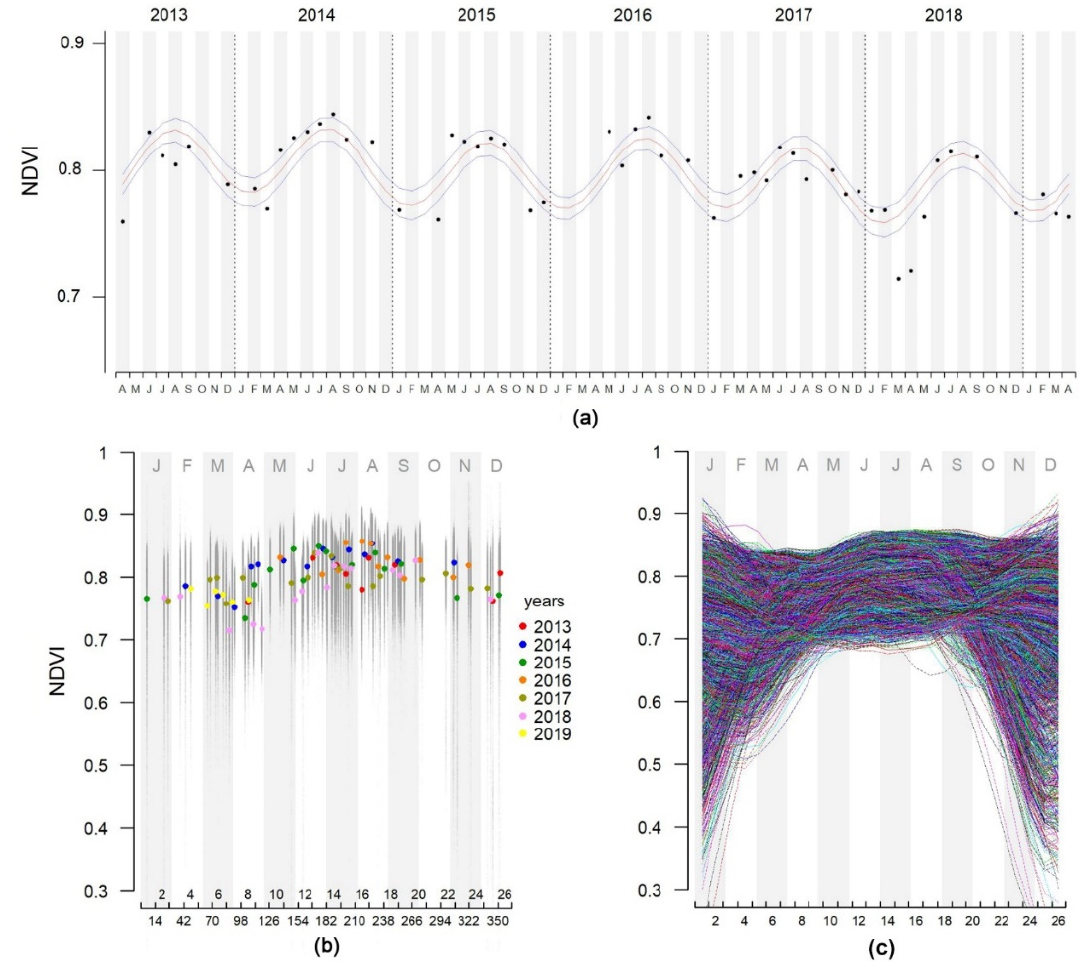
Figure 4. Variations of the NDVI values extracted from the Landsat 8 images covering the Mount Conero area (East coast of Central Italy) relating to the period April 2013-April 2019. ( a ) Inter-annual NDVI variations fitted by a harmonic regression. Red line represents the fitted values and the blue ones the confidence interval. Black points are the monthly median NDVI values. ( b ) Intra-annual variation. The colored circle (according to the year of acquisition) is the median value of the scene. The gray line is the range of variation of the pixels of the scene. The scenes are distributed during the year in agreement by the DoY. X-axis: above the bi-weeks of the year, below the DoY. ( c ) The mean intra-annual NDVI seasonality variation of the forests described by the 7292 bi-weekly pixel-based NDVI times series. X-axis is the bi-weeks of the year.